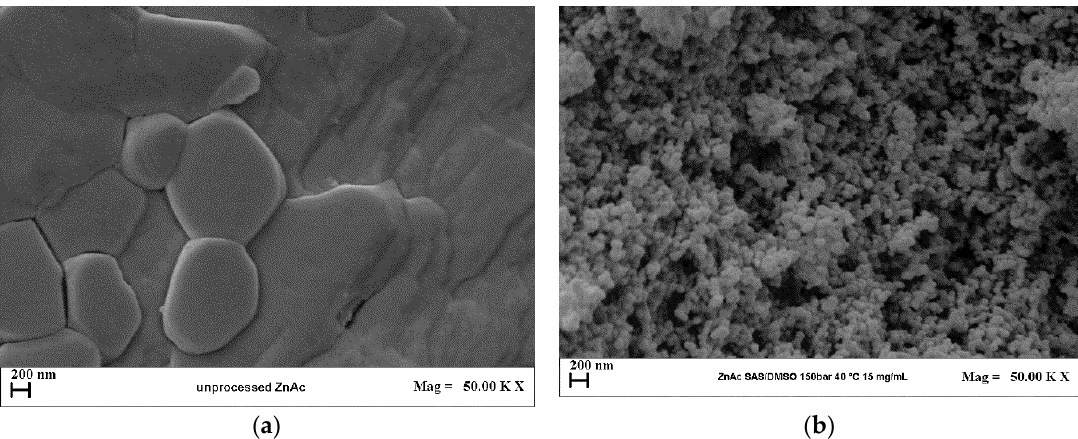
Figure 1. Field emission scanning electron microscope (FESEM) images of unprocessed zinc acetate (ZnAc) ( a ) and supercritical antisolvent (SAS) ZnAc nanoparticles ( b ) precipitated from dimethylsulfoxide DMSO at 150 bar, 40 °C, and 15 mg × mL − 1 .